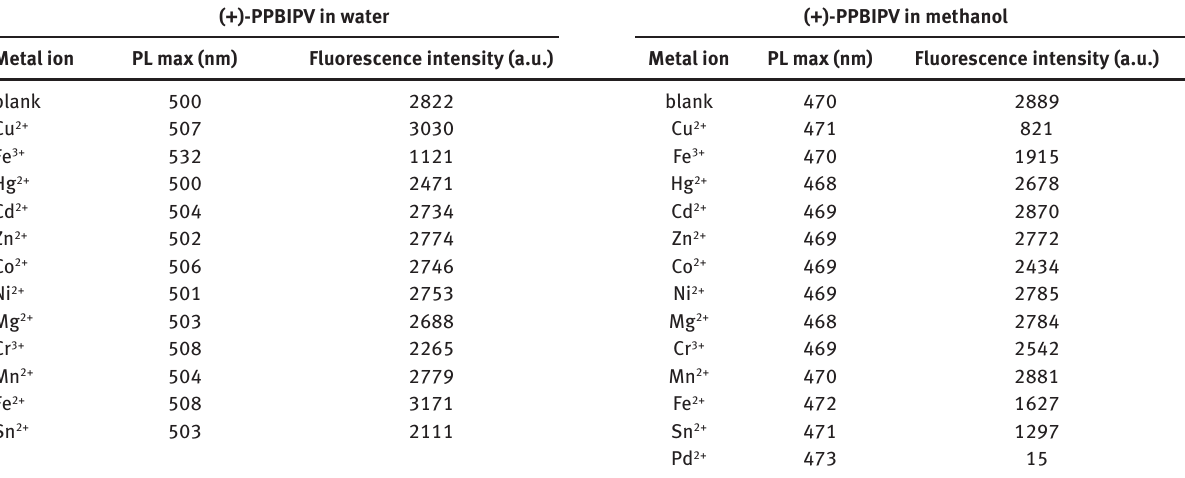
Table 2: PL max (nm) and maxima of fluorescence intensity of (+)-PPBIPV with different metal ions.